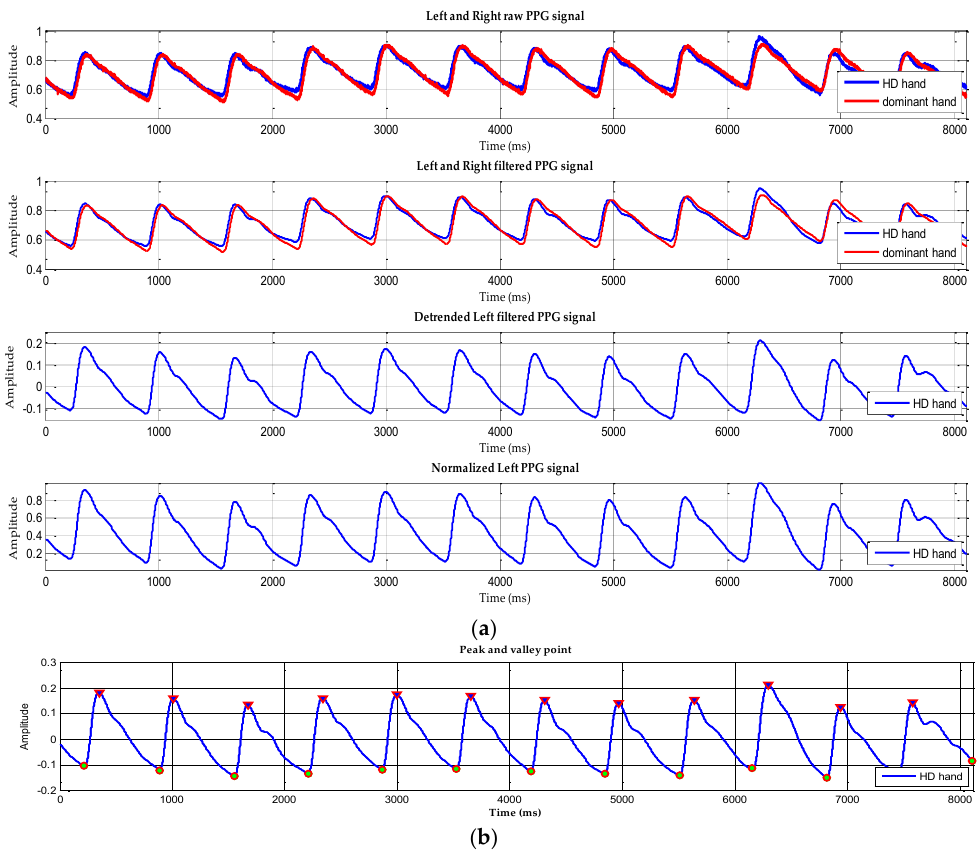
Figure 7. ( a ) The process data preprocessing; ( b ) Final result of peak and valley detection on selected twelve peak PPG signals.